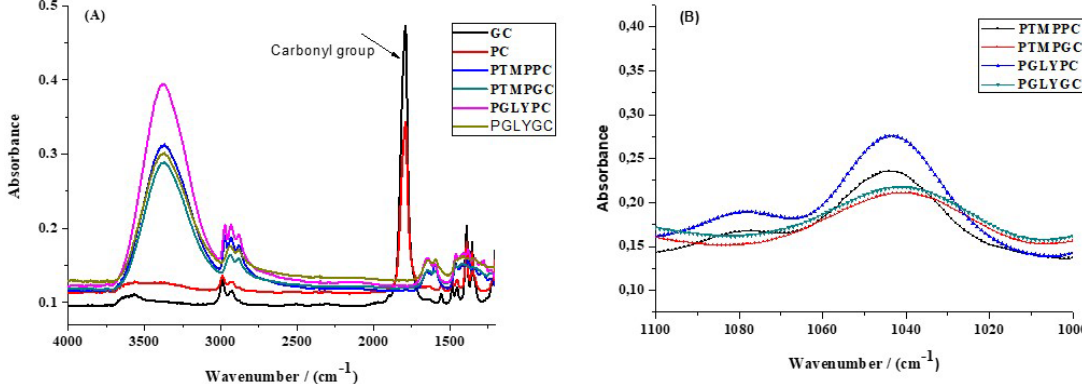
Figure 2. (A) GC, PC, PTMPPC, PTMPGC, PGLYPC and PGLYGC infrared spectra; (B) PTMPPC, PTMPGC, PGLYPC, and PGLYGC infrared spectra in the CH2-O- ethers linkages